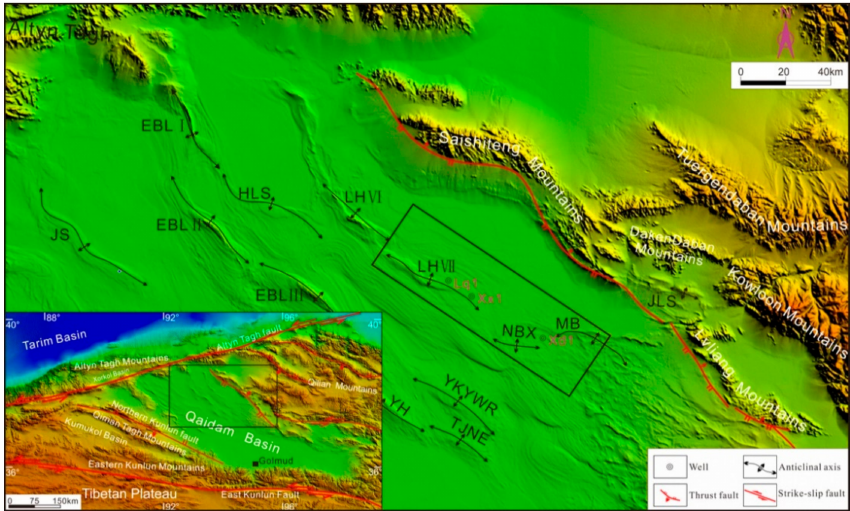
Figure 1. Structural location of the Lenghuqi area in the northern margin of the Qaidam